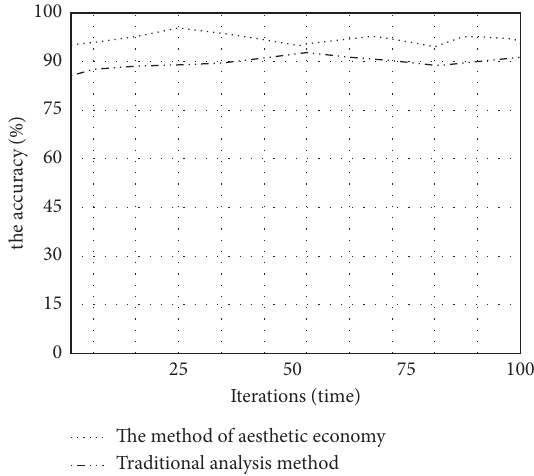
Figure 4: Comparison of two different evaluation